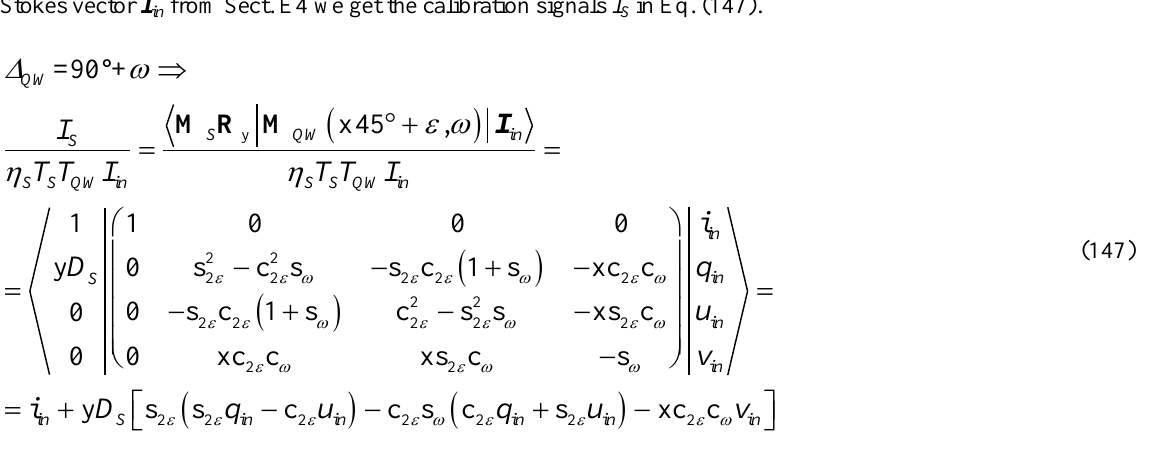
Special cases: For the investigation of the effect of the phase-shift error ω we neglect the rotation error ε in Eq. (147) and get the calibration signals in Eq. (148) and the gain ratios in Eq.